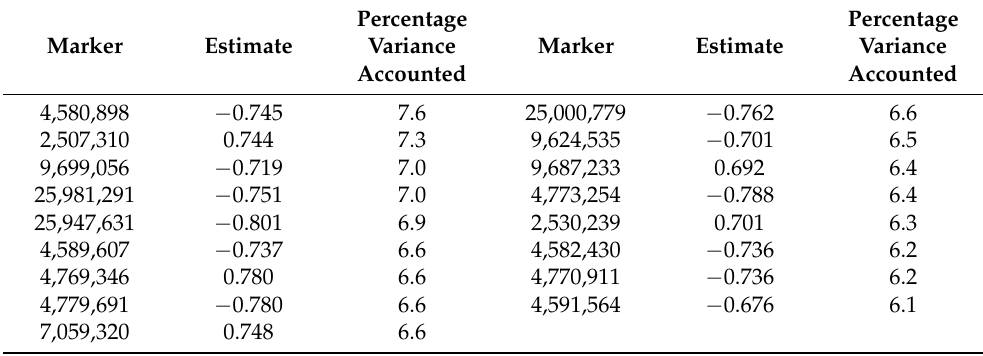
Table 3. Selected molecular markers (significant at the 0.001 level) related to the seed vigor.